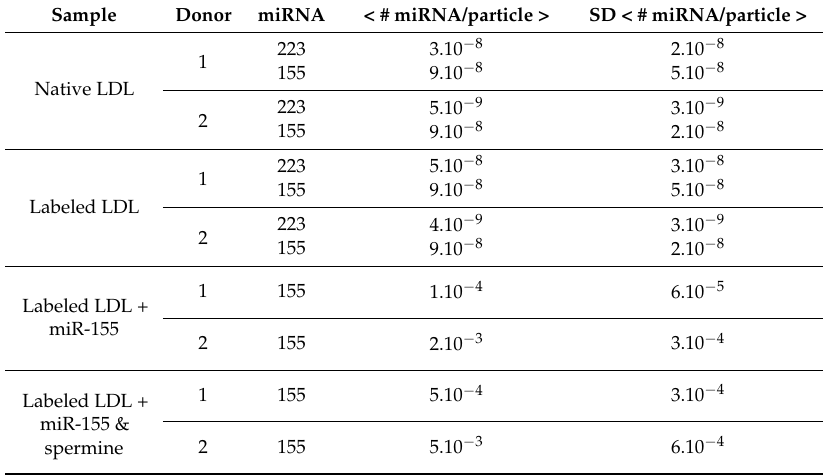
Table 3. * miRNA content of LDL particle